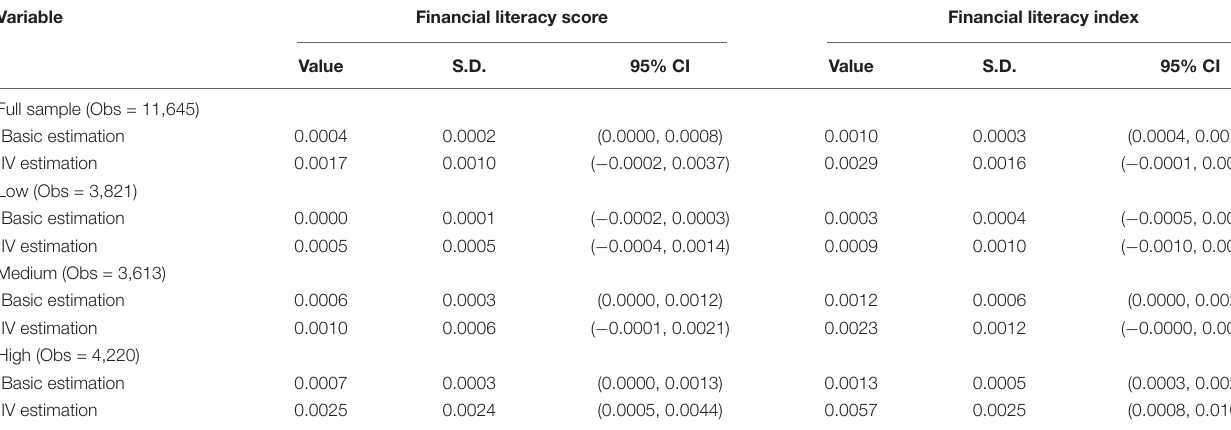
TABLE 9 | Mediating effects at different levels of ICTs